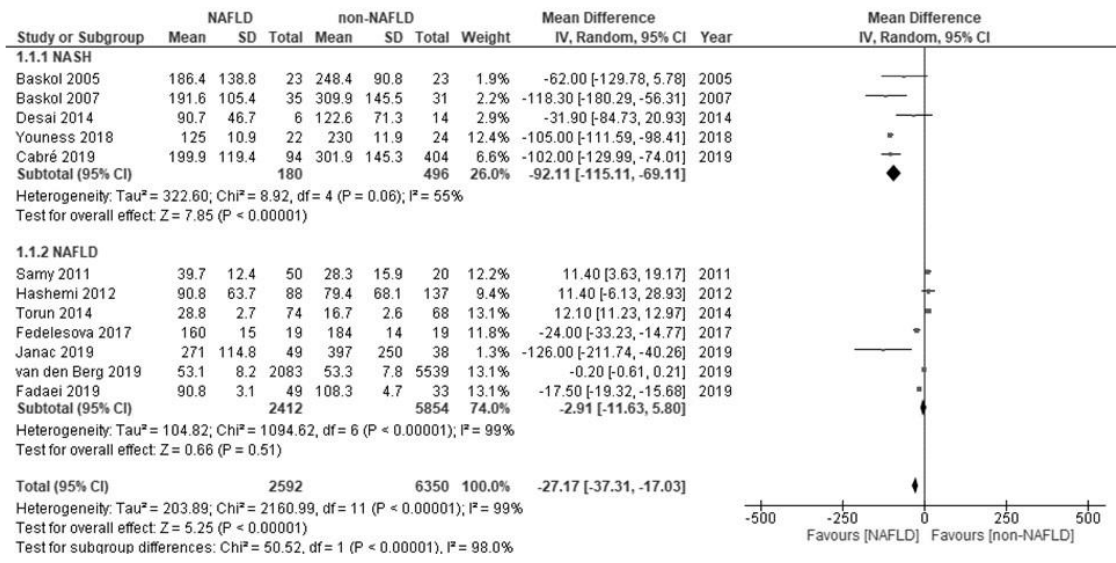
nonalcoholic fatty liver disease (NAFLD), as diagnosed based on ultrasonography or laboratory data (lower